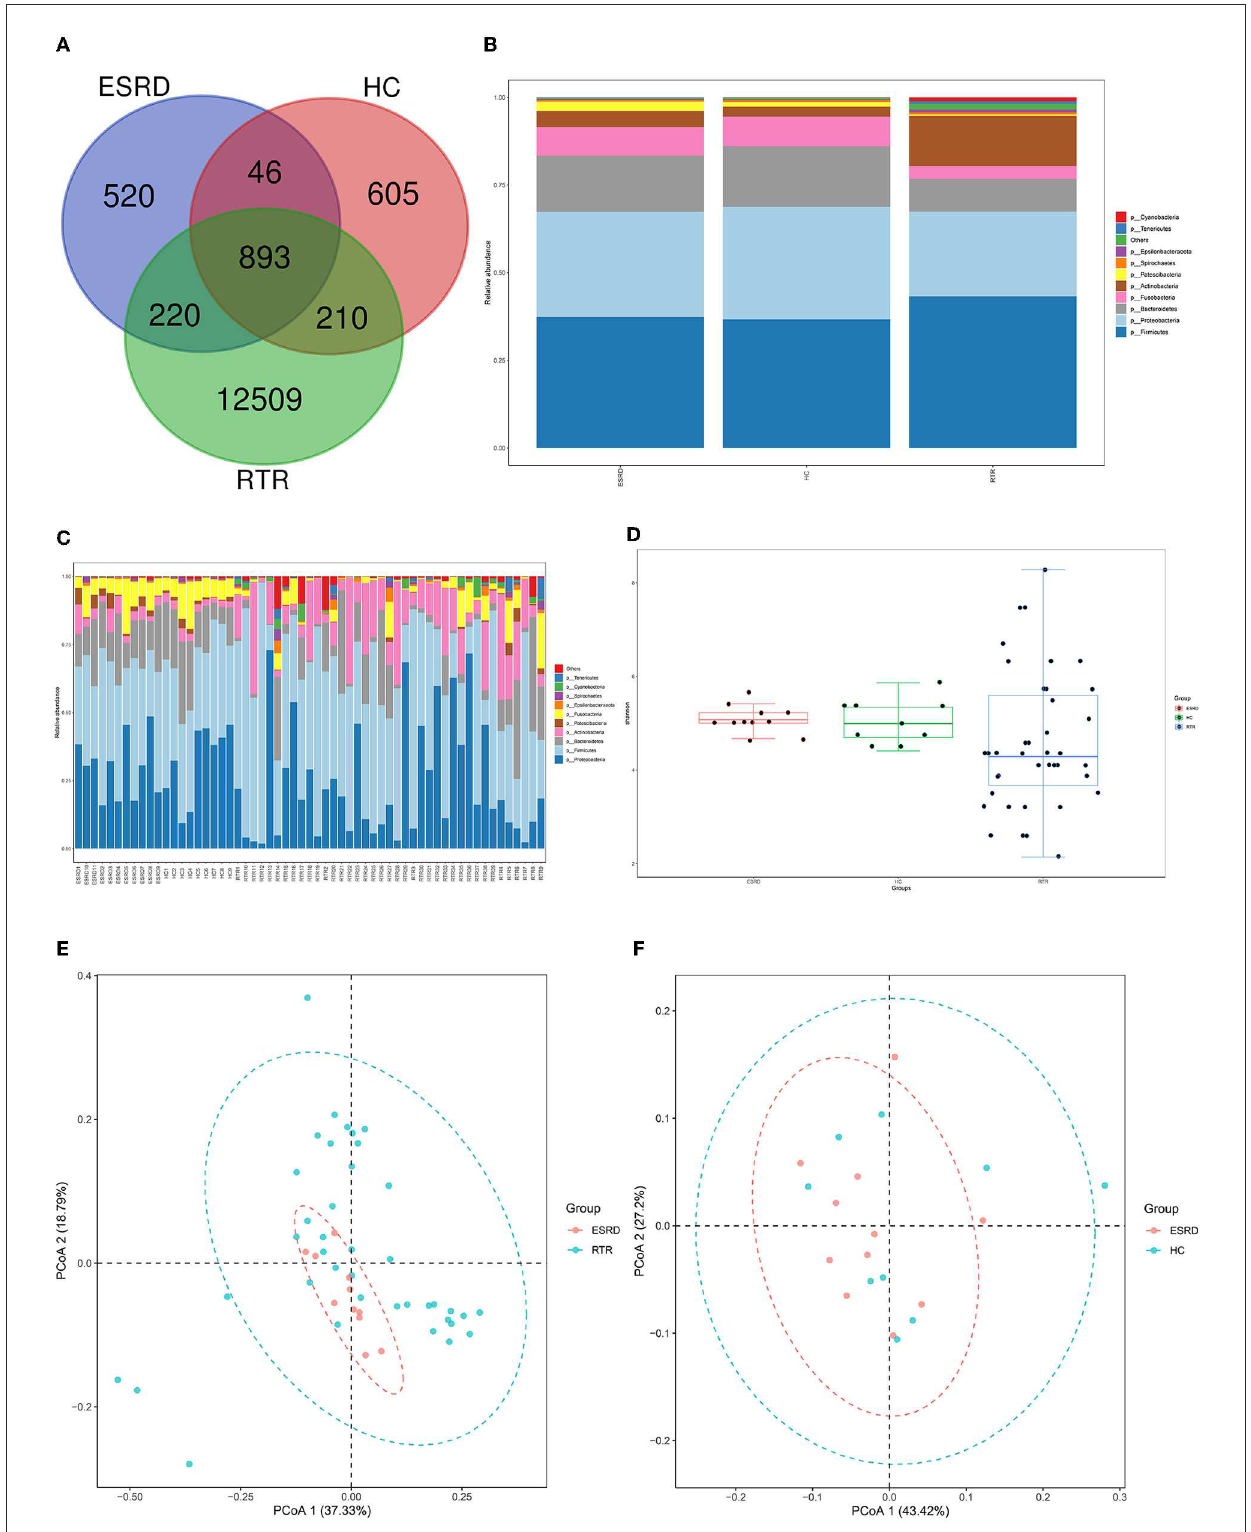
FIGURE1 Composition characteristics of salivary microbiota in RTR, ESRD, and HC groups: (A) Venn graph for the OTUs of RTR, ESRD, and HC groups; (B) Salivary species composition of RTR, ESRD, and HC groups in the phylum level; (C) Salivary species composition of each individual in the phylum level; (D) Shannon index of RTR, ESRD, and HC groups; (E) PCoA graph of RTR and ESRD groups; (F) PCoA graph of ESRD and HC